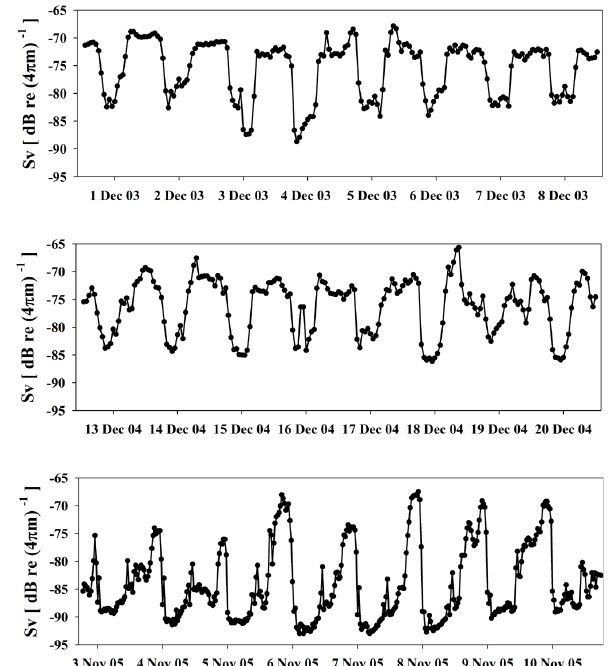
Fig. 11. Subset of backscatter strength hourly data at 40m depth in presence of twilight diel vertical migration pattern for the three deployments. Label at